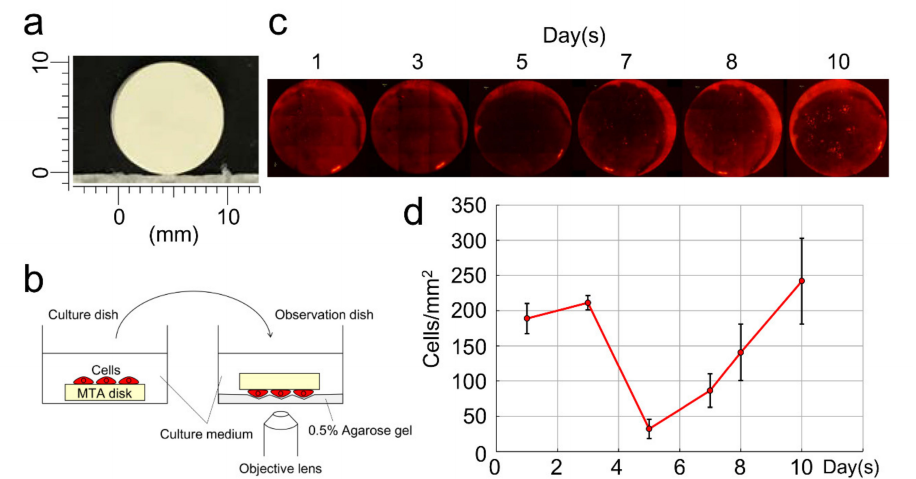
Figure 2. Cytotoxicity of mineral trioxide aggregate (MTA) based on the cell proliferation rate of DsRed-PPU7 cells cultured in standard medium. ( a ) MTA disk constructed using a silicon mold (10 mm in diameter with 1.8 mm thickness). ( b ) Schema for observation of living DsRed-PPU7 cells on MTA disks using agarose gel. ( c ) Fluorescence microscope image of DsRed-PPU7 cells on MTA disks on Days 1, 3, 5, 7, 8 and 10. ( d ) Changes in the number of DsRed-PPU7 cells on Days 1, 3, 5, 7, 8 and 10. Cells were counted by randomly selecting nine squares (300 µ m × 300 µ m) using Image J ( n =